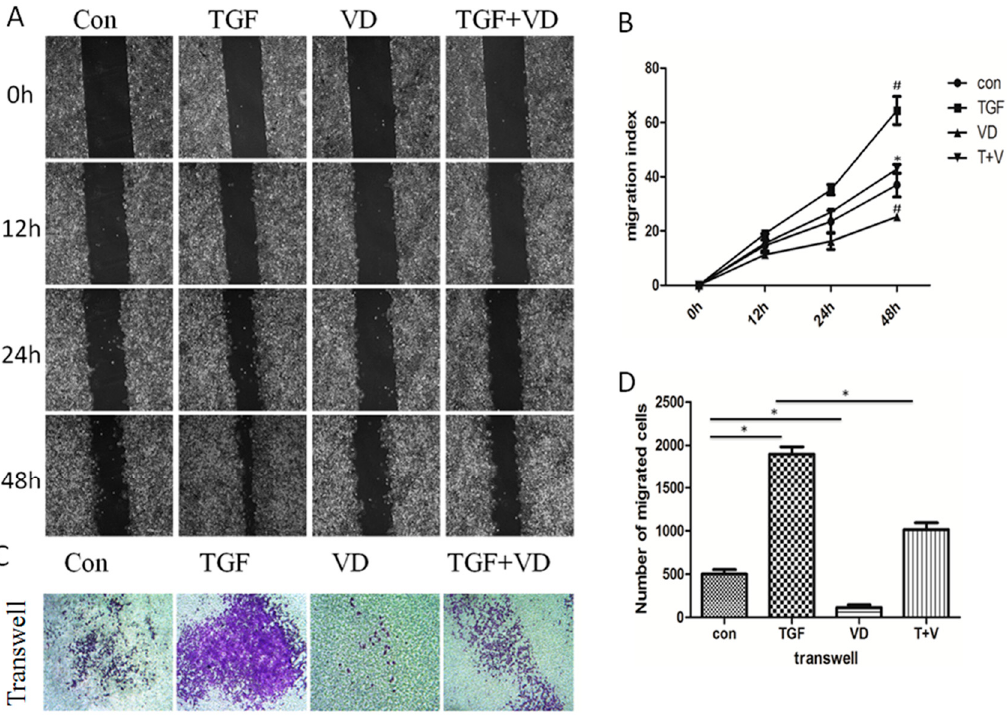
Figure 5. 1 α ,25(OH) 2 D 3 prevents TGF- β -induced invasion and metastasis in A549 cells. A549 cells were cultured in 0.5% FBS DMEM medium containing TGF- β and/or 1 α ,25(OH) 2 D 3 for 48 h, then wound healing and transwell assay were performed. ( A ) Representative pictures of the wound area obtained at 0, 12, 24 and 48 h after scratching (100× magnification); ( B ) Migration index (%) = [(the initialized width of the scratch) − (the final width of the scratch)]/(the initialized width of the scratch). ( C ) Biocoat Matrigel Invasion Chambers (100 × magnification); ( D ) Counts of cells under a microscope. # p < 0.05 compared with the control group, and * p < 0.05 compared with the TGF- β -treated cells.